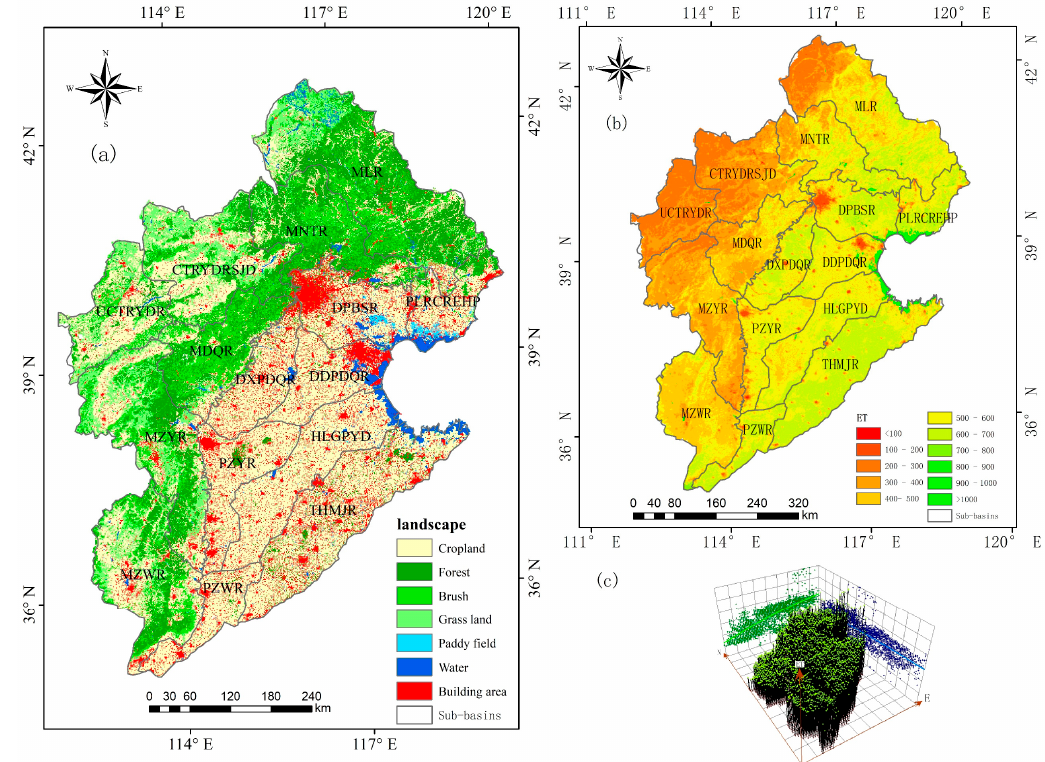
Figure 3. The distributions of land use ( a ) and evapotranspiration ( b ) and the spatial trend of ET ( c ) in 2014 in the Hai Basin. The units of evapotranspiration shown in ( b ) are mm. ( c ) was created using the ArcGIS trend analysis tool.